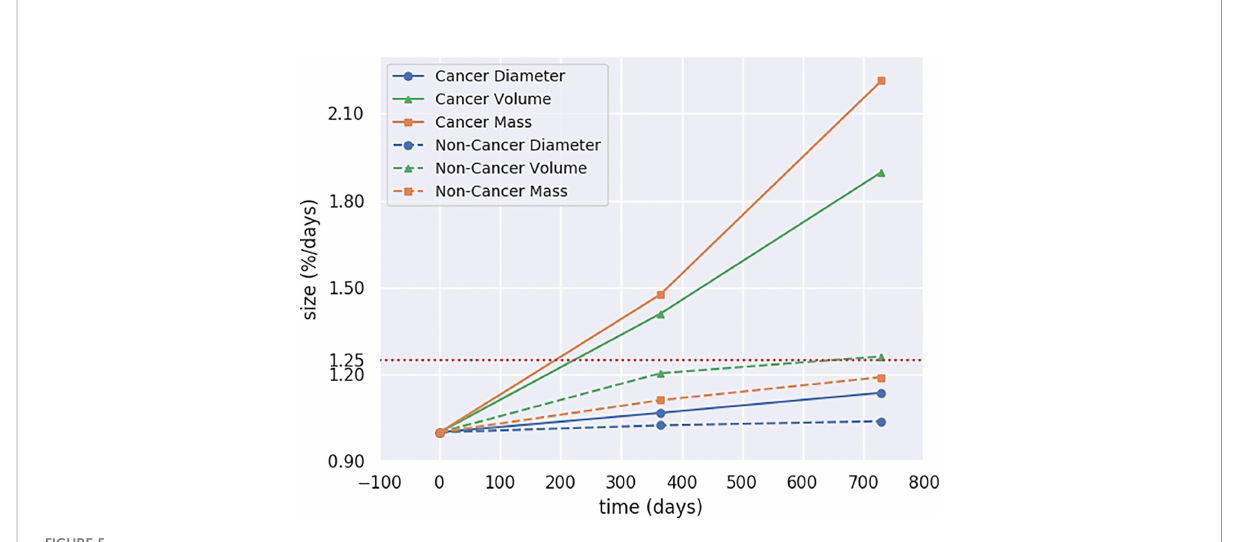
FIGURE 5 Progression in mass, volume, and diameter of SSNs.